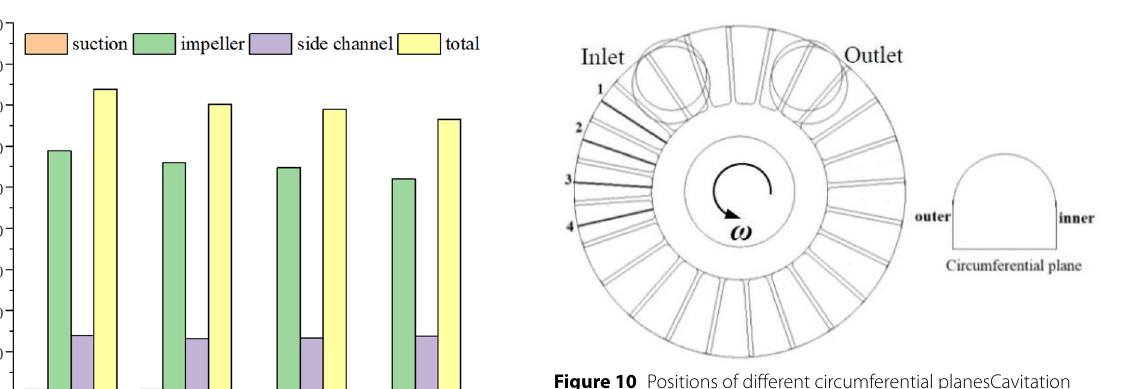
Figure 9 Values of vorticity for different cavitation numbers